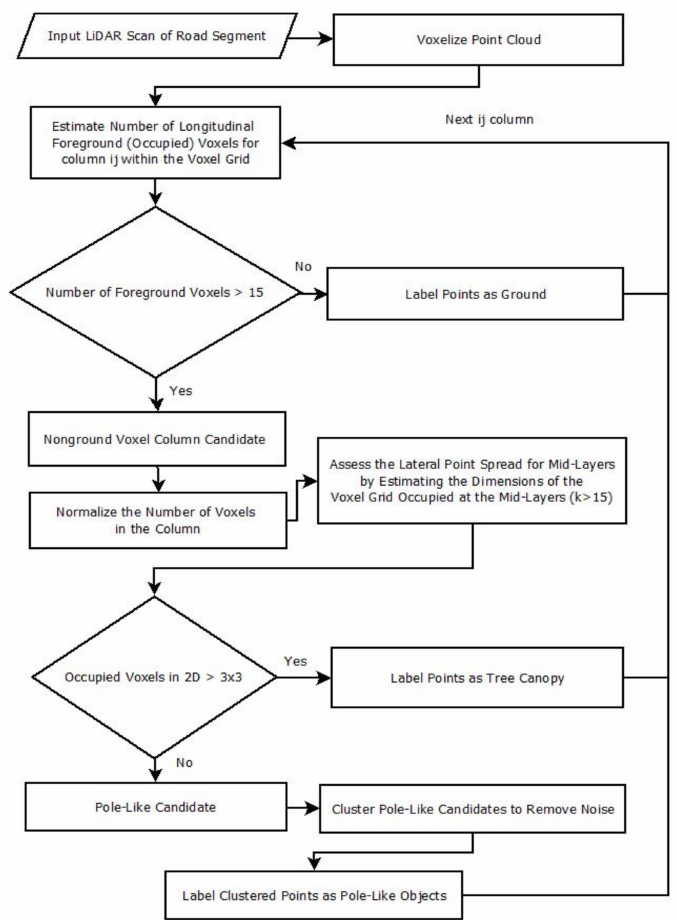
Figure 5. Segmentation method proposed for pole-like object and tree canopy extraction.